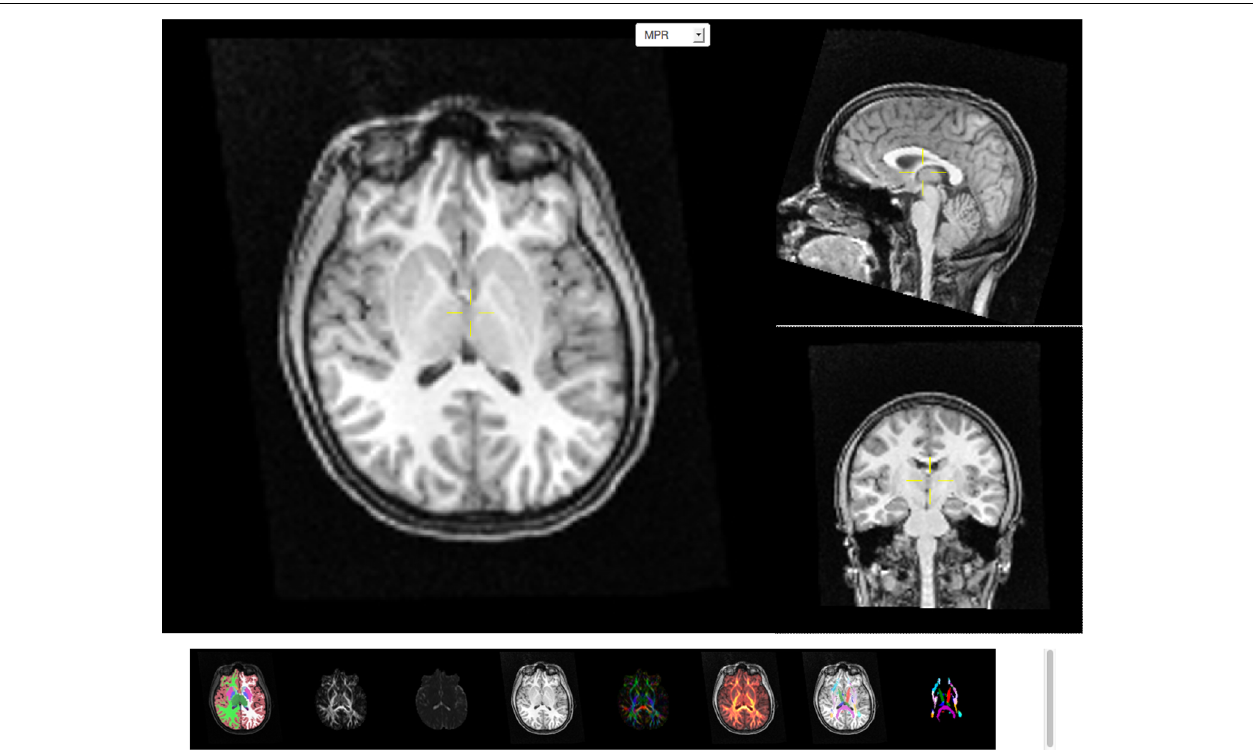
FIGURE 4 | Screen capture of the image viewer application. A multi-planar reconstruction displays axial (top left), sagittal (top right), and coronal (middle right) images linked by a common cross-hair (pale yellow). Below, a row of axial thumbnail images depict available image modalities such as (left to right) fused sub-cortical segmentation with T1-weighted anatomical image, fractional anisotropy (FA), mean diffusivity, T1-weighted anatomical image,